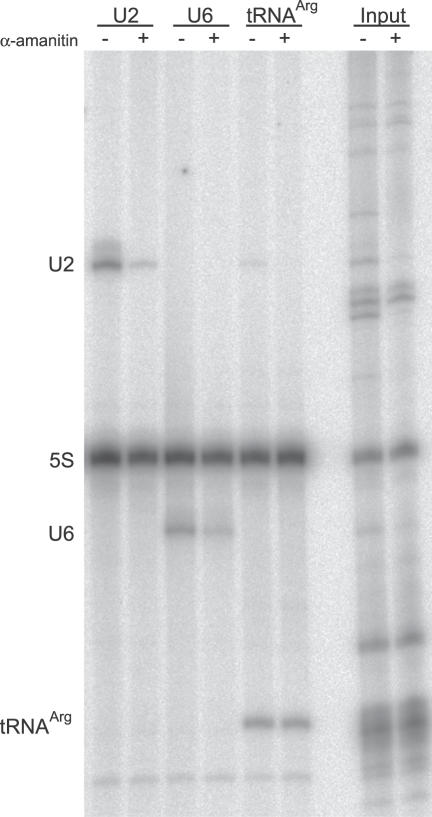
α-Amanitin Reduces Endogenous U6 snRNA ExpressionHeLa cells were transfected with a tRNAArg maxigene and 16 h later treated with 10 μg/ml α-amanitin or left untreated. After 3 h, 250 μCi [32P] orthophosphate was added to the medium for 6 h. Total RNA was collected and 5S rRNA along with tRNAArg, U2 and U6 snRNAs were hybrid selected with biotinylated complementary oligos. Hybrid-selected RNA was separated on a denaturating polyacrylamide gel and exposed to PhosphorImager plates. The 5S rRNA bands served as a loading control. Three biological replicates were analyzed and a representative gel is shown.